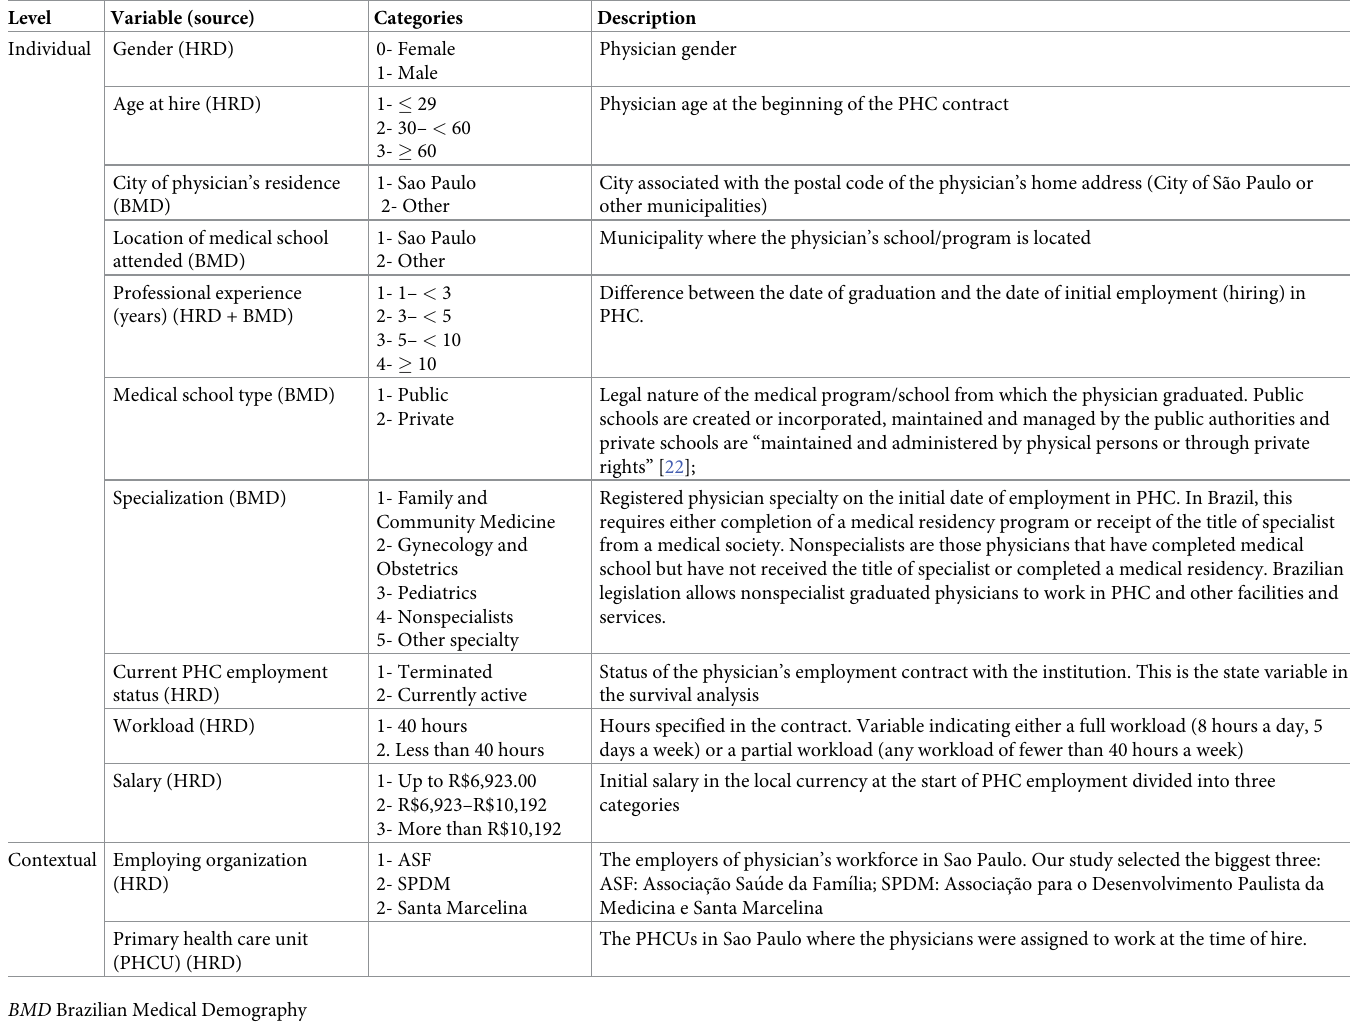
Table 1. Description of the individuals and contextual